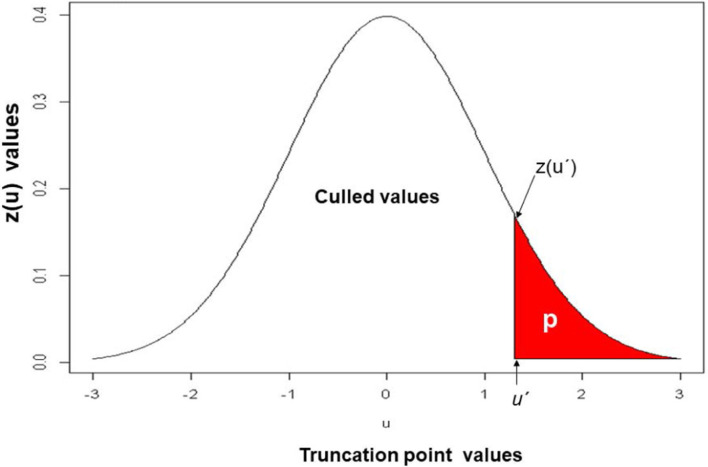
Theoretical relationship between the truncation points (u), the proportion retained (p), and the density values [z(u)] of the truncation points (after Ceron-Rojas et al., 2019).